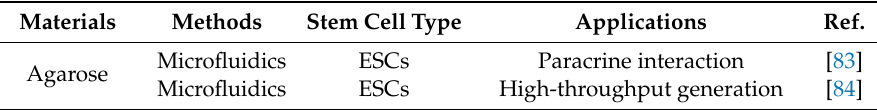
Table 4. Examples of agarose-based stem cell